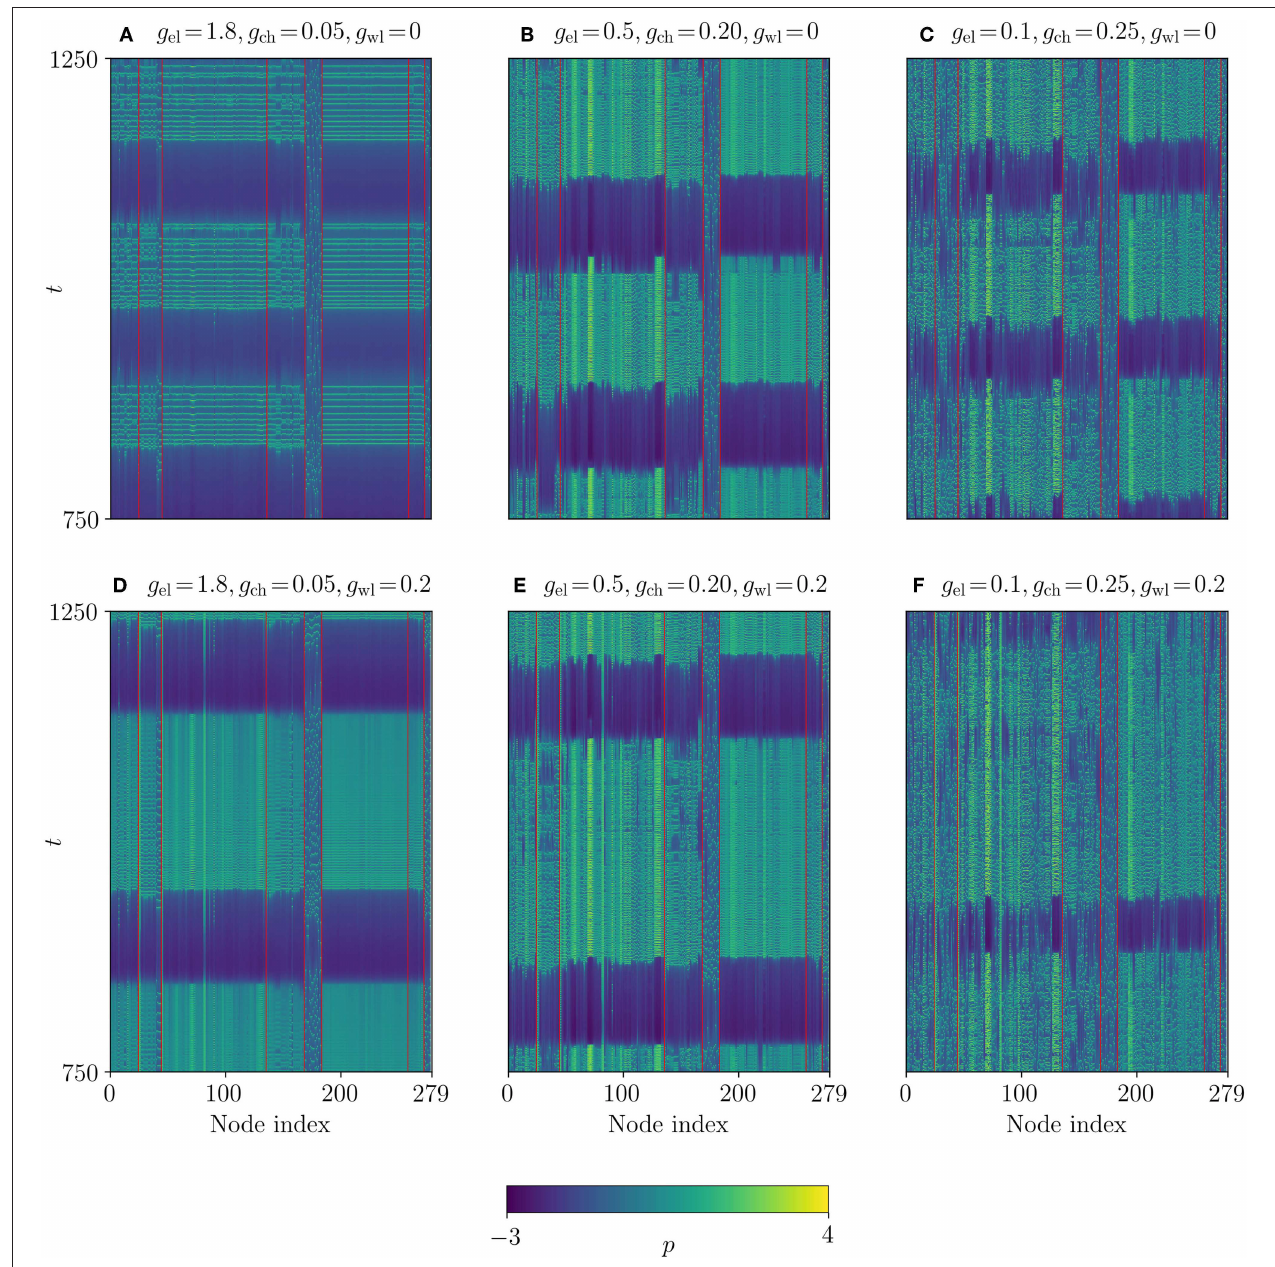
FIGURE 10 | Space-time plots of the dynamical correlation-based network. The system parameters are the same as in Figure 3 , except for g wl . (A–C) . Temporal evolution of the p -variable for different g el and g ch with g wl = 0. (D–F) Similar plots for g wl = 0.2. The values of all coupling strengths are summarized in Table 2 . Red lines separate different communities. The time series are identical to Figure 7 , but for a different ordering of